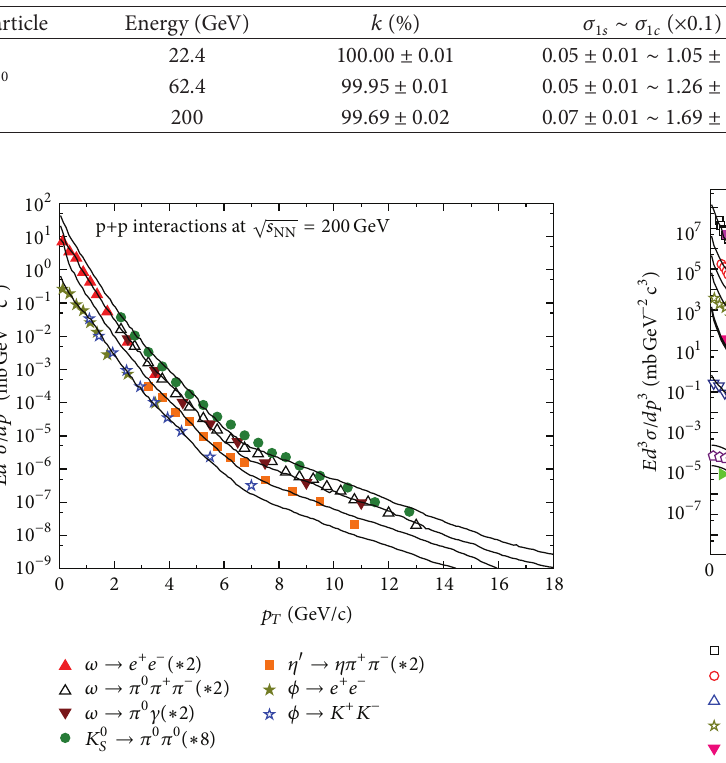
Figure 1: Invariant differential cross-section of neutral mesons = 200GeV in various decay measured in p+p collisions at √𝑠 NN modes. Experimental data measured by the PHENIX Collaboration Figure 2: Invariant differential cross-sections of different particles [18] are shown by the scattered symbols. Our results calculated from = 200 GeV in various decay measured in p+p collisions at √𝑠 NN the cylinder model are shown by the curves. modes. Experimental data measured by the PHENIX Collaboration [18] are shown by the scattered symbols. Our results calculated from the cylinder model are shown by the